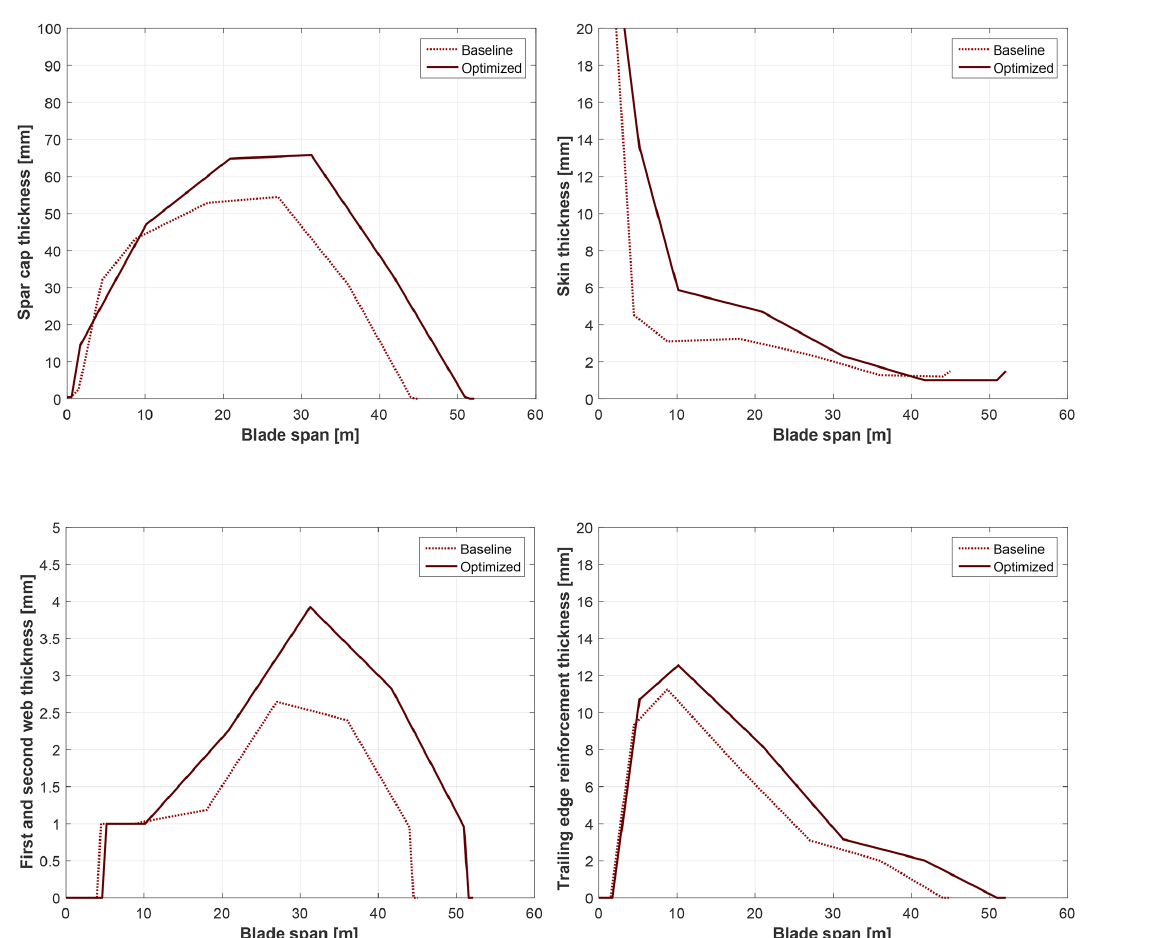
Figure 5. Structural thickness distributions of the baseline and the optimized 2.2MW wind turbine